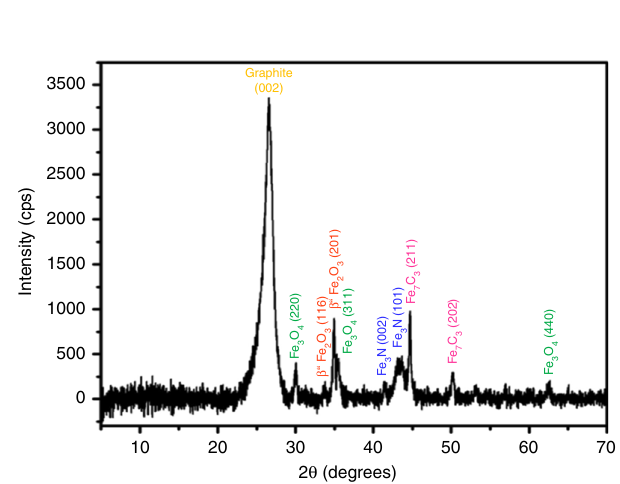
Fig. 2 PXRD characterization. PXRD pattern of Fe-L 1 @EGO-900 with indices of peaks with the pattern of Fe 3 O 4 , Fe 3 N, β ″ -Fe 2 O 3 , Fe 7 C 3 , and